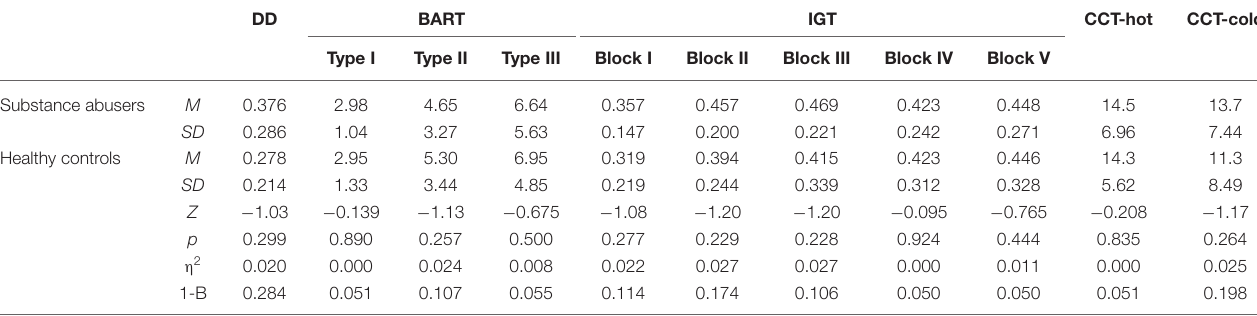
TABLE 2 | Means and standard deviations of the decision-making tasks.